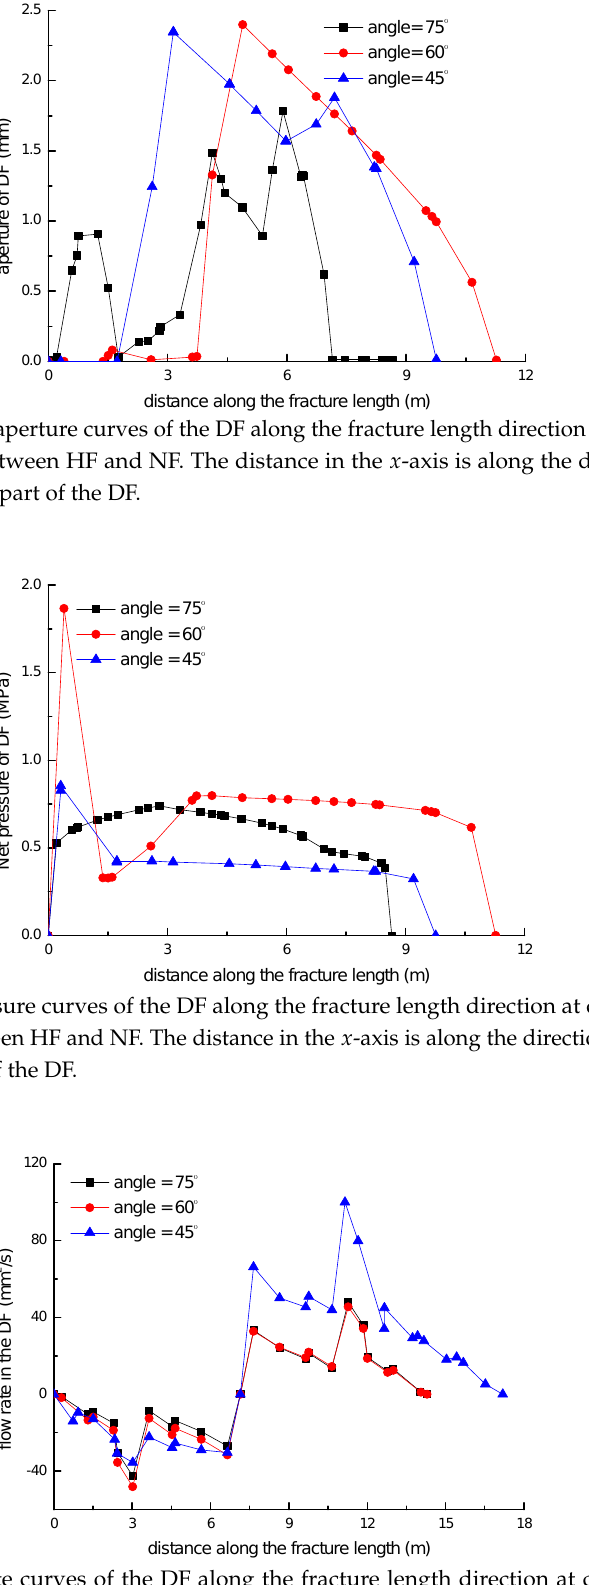
Figure 19. The flow rate curves of the DF along the fracture length direction at different levels of intersection angle between HF and NF. The distance in the x -axis is along the direction from the lower part to the upper part of the